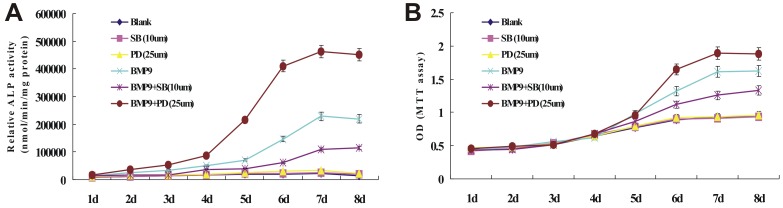
Opposing effects of p38 and ERK1/2 on BMP9-induced ALP activity is correlated with the change of cell proliferation.(A) Effect SB203580 and PD98059 on BMP9-induced ALP activity in C3H10T1/2 cells. Subconfluent C3H10T1/2 cells were infected with Ad-BMP9 (MOI = 5) or Ad-GFP (MOI = 5), followed by treatment with SB203580 (25 µM) or PD98059 (10 µM), ALP activity was quantitative measured at the indicated time points. Each assay condition was carried out in triplicate in at least two independent batches. (B) Effect of SB203580 and PD98059 on BMP9-induced cell proliferation in C3H10T1/2 cells. Subconfluent C3H10T1/2 cells were infected with Ad-BMP9 (MOI = 5) or Ad-GFP (MOI = 5), followed by treatment with SB203580 (25 µM) or PD98059 (10 µM), cell proliferation was monitored by MTT assay at the indicated time points. Each assay condition was carried out in triplicate in at least two independent batches.